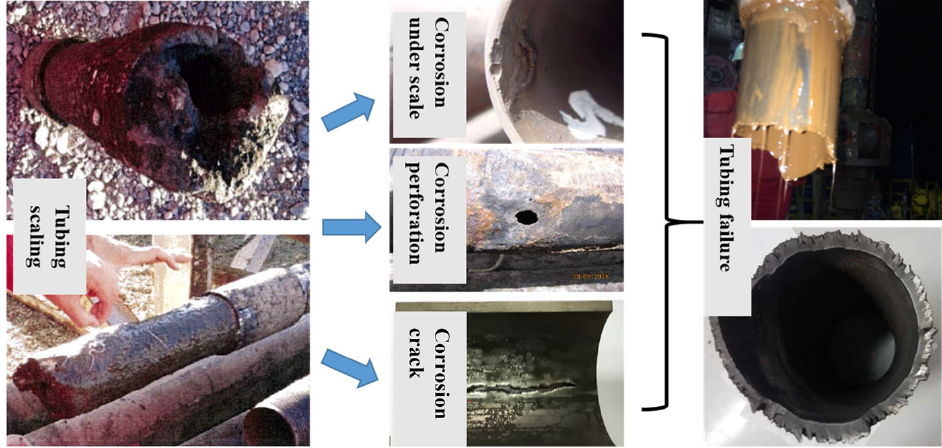
Figure 1. Morphological Diagram of On-site Tubing Scaling and Corrosion under Scale.